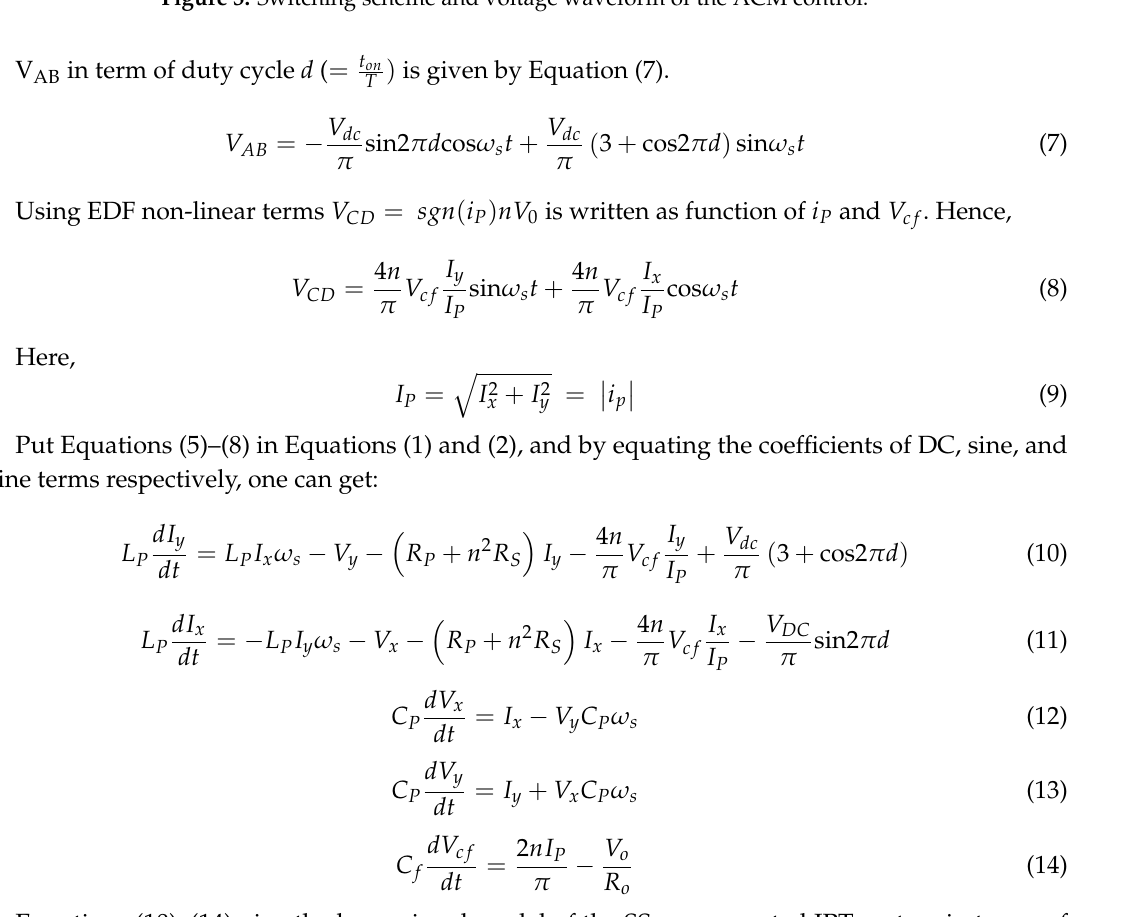
Figure 3. Switching scheme and voltage waveform of the ACM control.